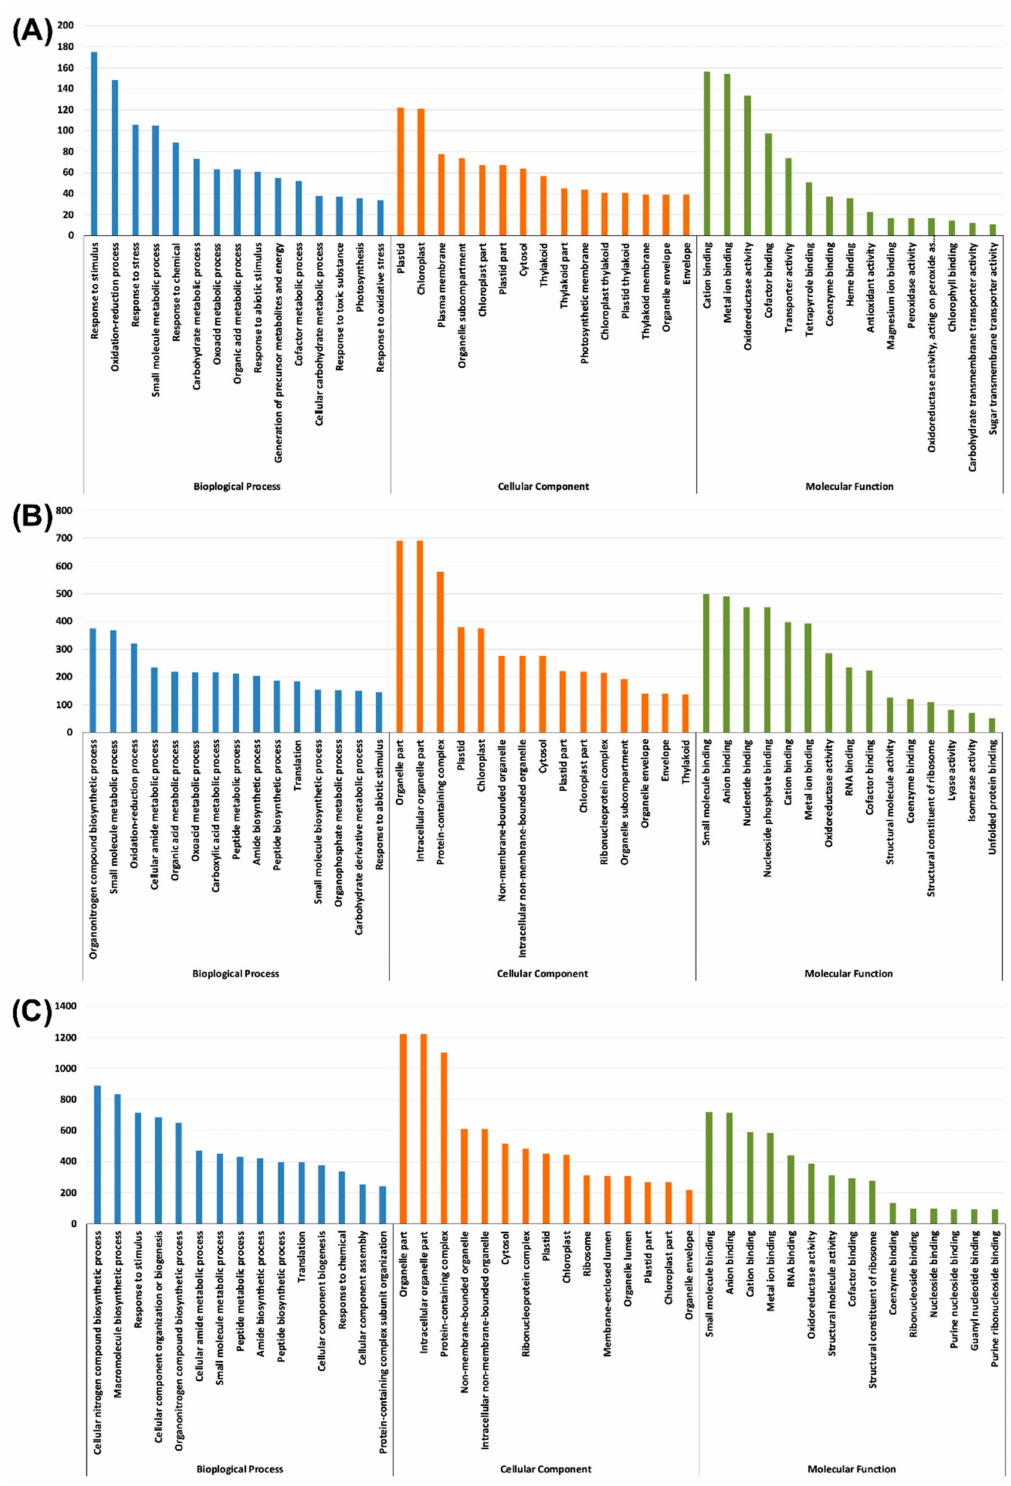
Figure 5. Functional gene ontology annotations of di ff erentially expressed genes (DEGs) under Fe and Zn stresses in the shoot: ( A )–Zn; ( B )–Fe; and ( C )–Fe–Zn. For graphical representation, we have the top 15 significant terms under each category viz ., biological process (blue), cellular component (orange), and molecular function (green). The complete list of terms along with the significance of FDR < 0.05 are mentioned in the Table